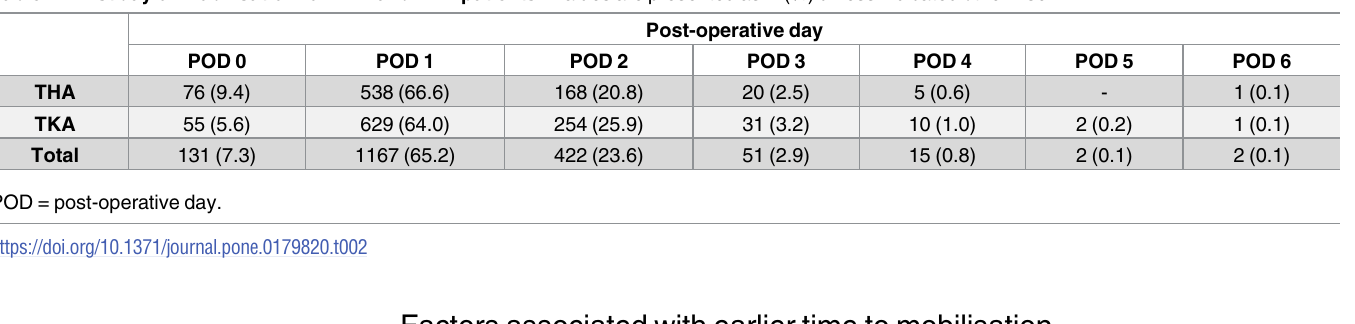
Table 2. First day of mobilisation for THA and TKA patients. Values are presented as N (%) unless indicatedotherwise.